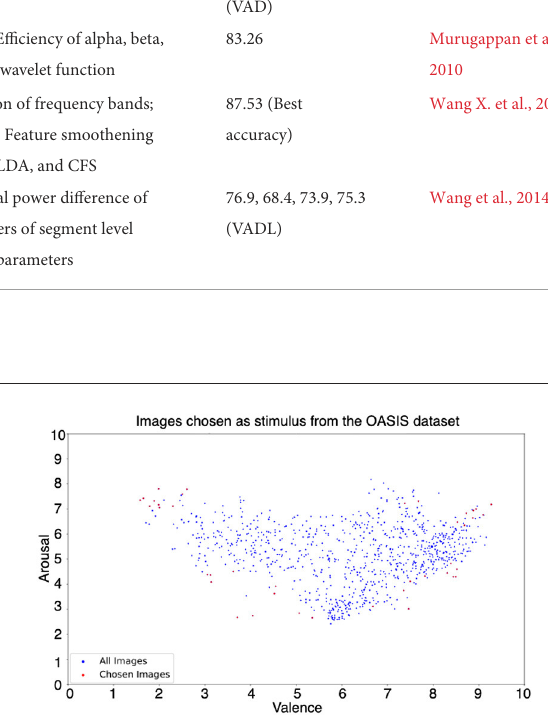
FIGURE1 Valence and arousal ratings of OASIS dataset. Valence and arousal ratings of the entire OASIS (Kurdi et al., 2016) image dataset (blue) and the images selected for our experiment (red). The images were selected to represent each quadrant of the 2D